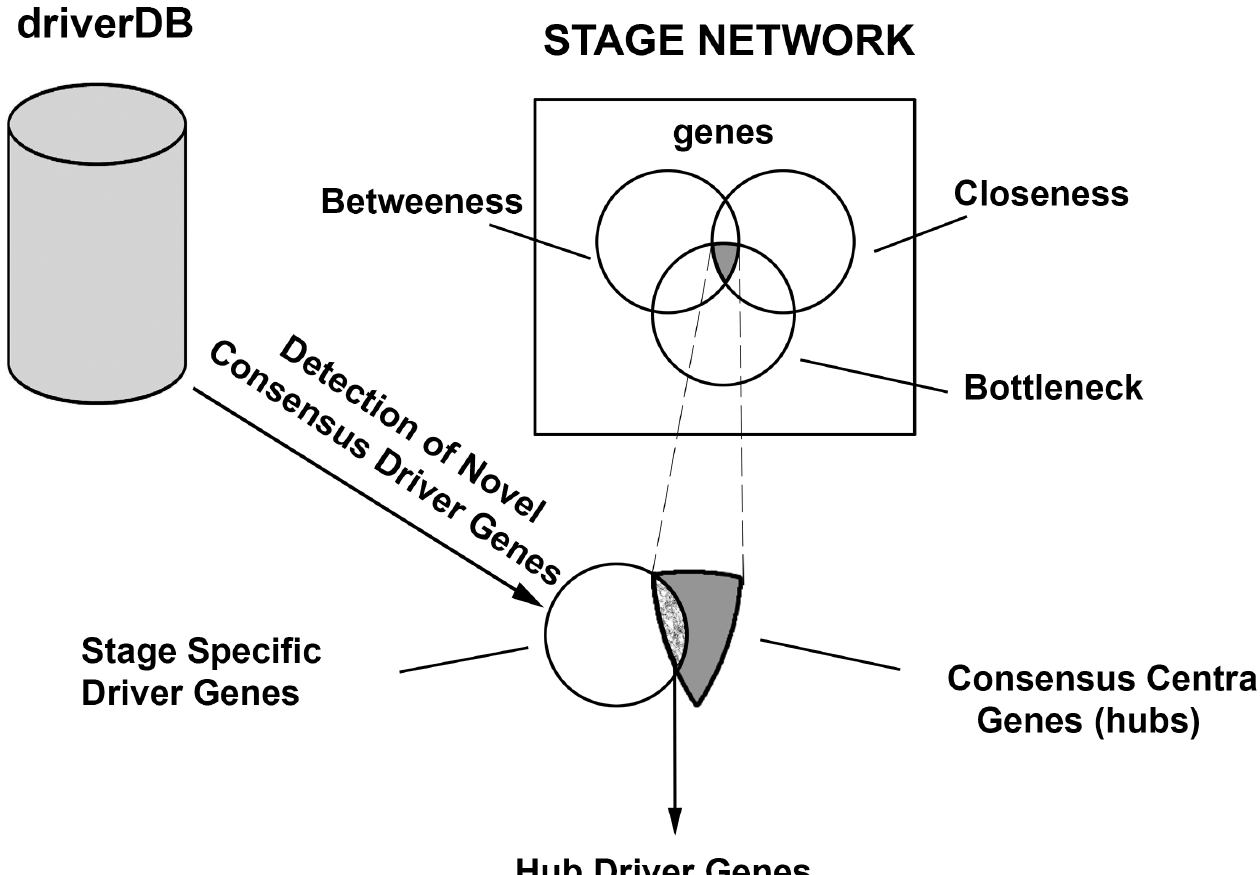
Fig 2. Identification of hub driver genes. Consensus novel driver genes were identified for each stage from driverDB data. Consensus central genes ( ‘ hubs ’ ) were identified from each stage-specific network. The overlap between these two sets of genes yields ‘ hub driver ’ genes for each